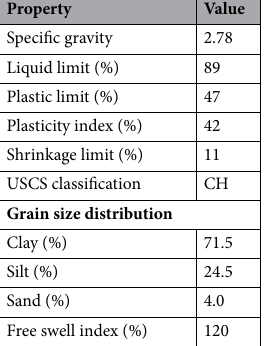
Table 1. Index properties of expansive subgrades considered 11